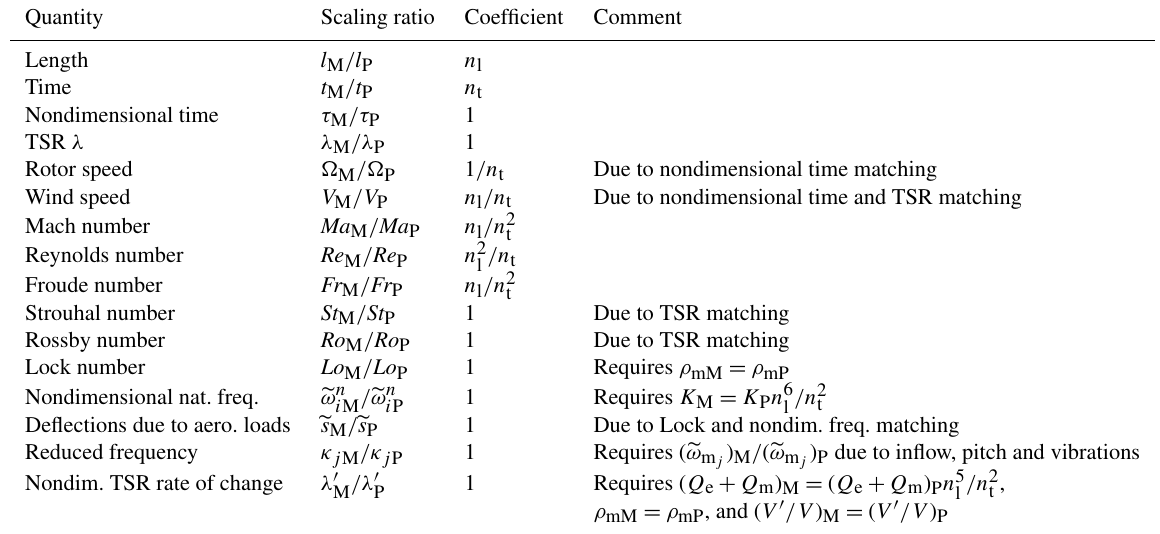
Table 1. Main scaling relationships relevant to a wind turbine. Additional scaling effects are discussed in the text. Quantity Scaling ratio Coefficient